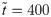
Test 1: Comparison between the FOM and DL-ROM APs at six points P1, …, P6.Left: FOM solution evaluated for μtest = (6.25, 6.25) cm at t˜=400 ms together with the points P1, …, P6. Right: APs evaluated for μtest = (6.25, 6.25) cm at points P1, …, P6. The DL-ROM, with n = 3, is able to to sharply reconstruct the AP in almost all the points and the main features are captured also for the points close to the scar.